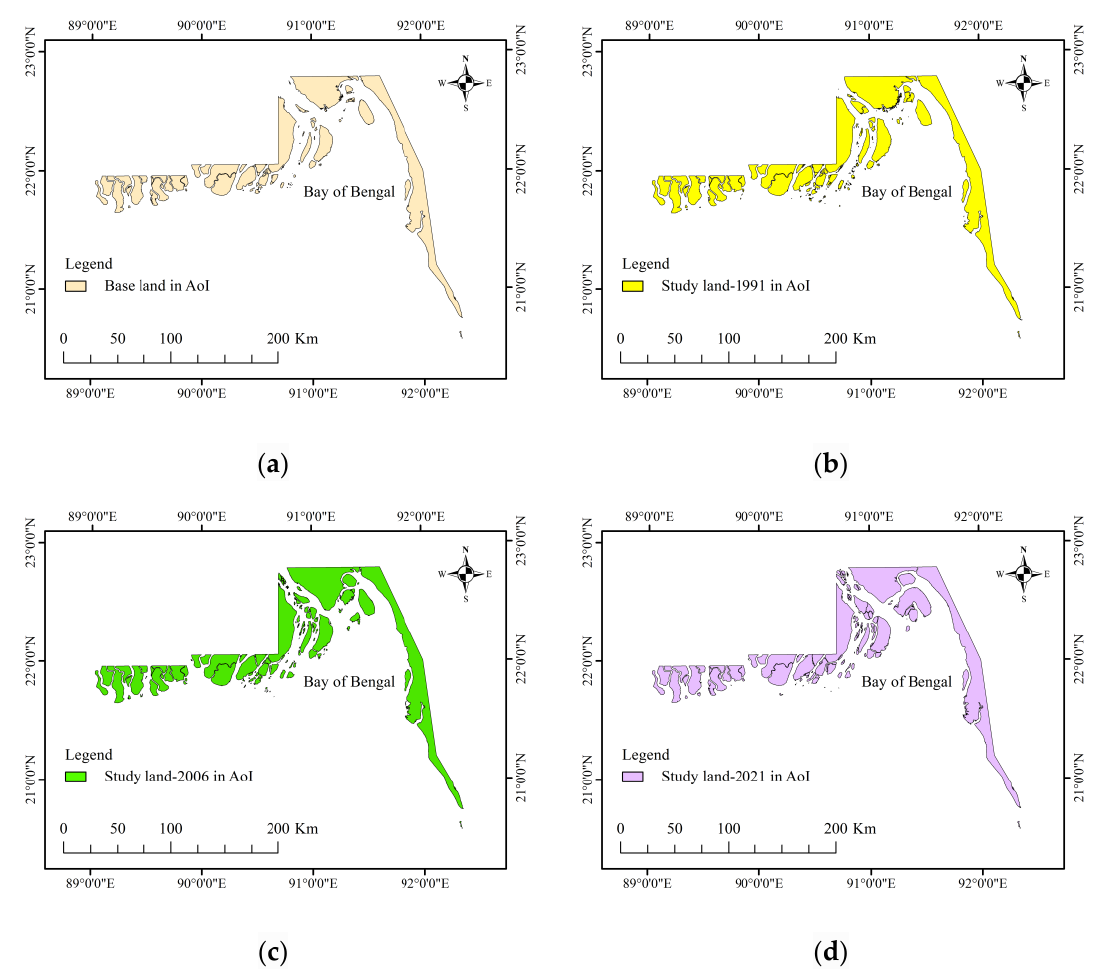
Figure 12. Area assessment using AoI Mask: ( a ) base land, ( b ) study land (1991), ( c ) study land (2006), and ( d ) study land (2021).